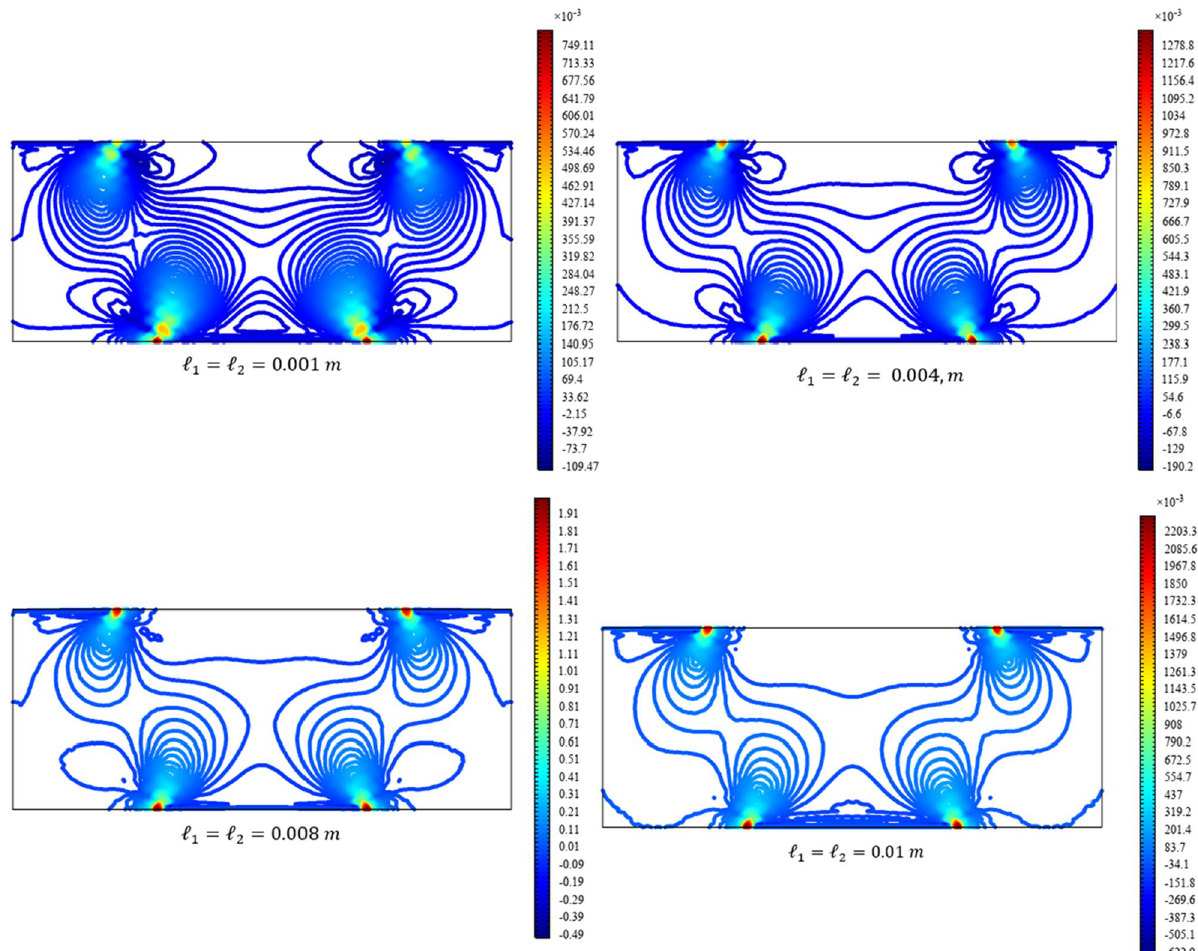
/ | u 0 | for different values of ℓ 1 and ℓ 2 (COMSOL (cid:30)